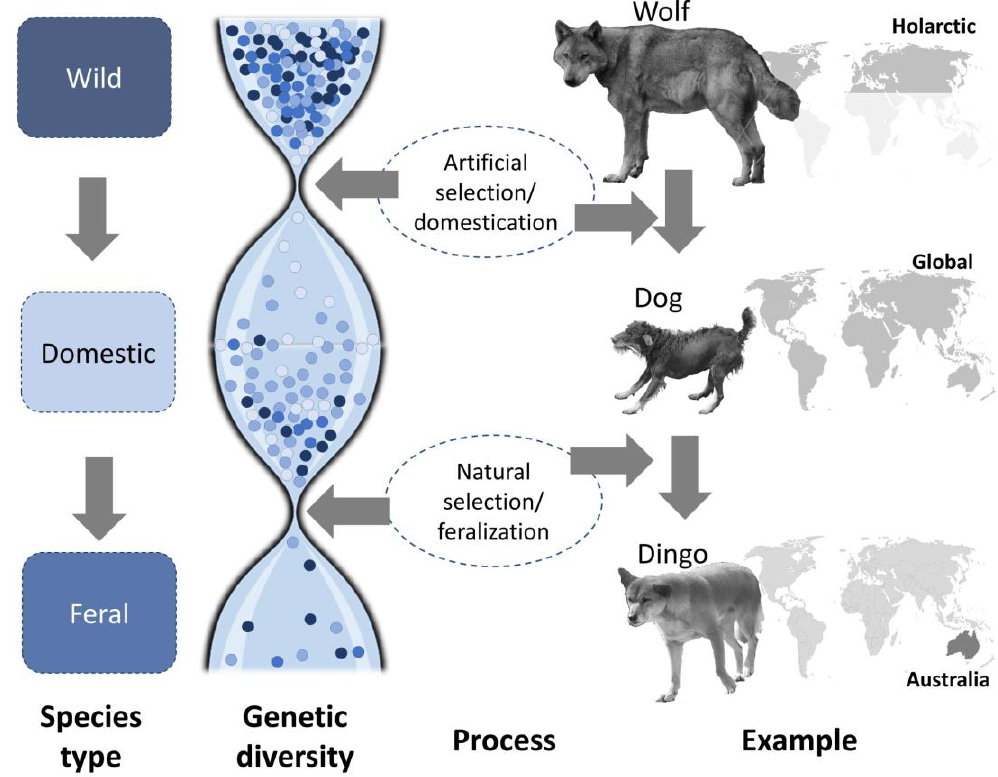
Figure 1. Conceptual framework using the wolf-dog-dingo continuum to illustrate the general processes of domestication (top) and feralization (bottom). Photos: T. Göttert .